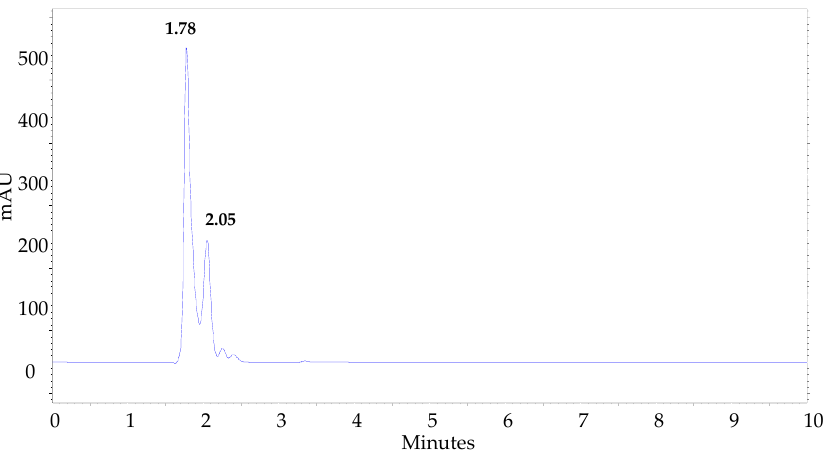
Figure 7. Chromatogram of the reaction mixture between L-cysteine and N -(2-aminoethyl)maleimide in H 2 O/MeOH 80:20.